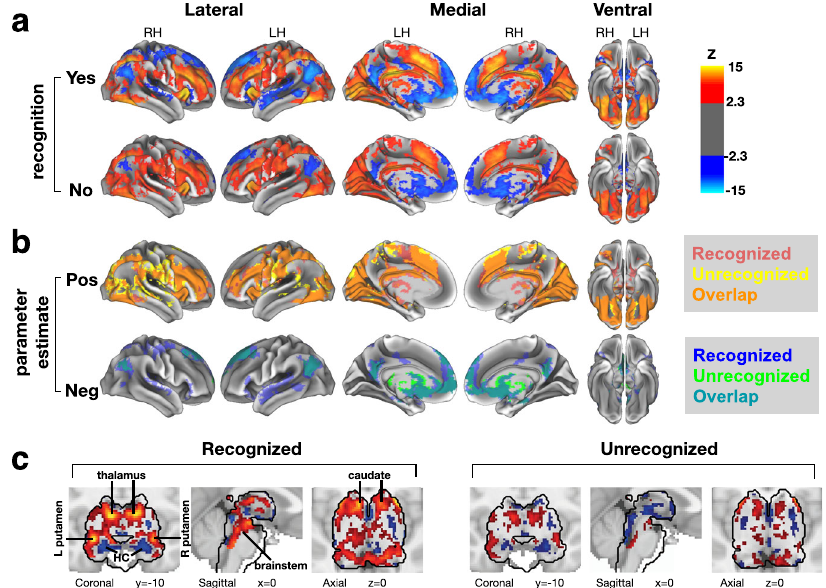
Fig. 2 Widespread brain response to liminal object stimuli. a Statistical parametric maps of BOLD response to liminal object stimuli that were subsequently recognized (Yes, top row) and unrecognized (No, bottom row), plotted on an in fl ated cortical surface template. b Same data as in a , showcasing the overlap in brain areas exhibiting positive ( “ pos ” ) and negative ( “ neg ” ) responses from baseline according to GLM parameter estimates. The positive and negative responses indicate activation and deactivation, respectively. c Same analysis as a presenting activity in subcortical regions only (within black contour), whereas the cortical activity shown in a is excluded for clarity (plotted on MNI152 template brain volume). The results are shown for voxels exhibiting signi fi cant p -values only, which were determined using cluster-based FWE-correction in FSL, with a voxel-de fi ning Z statistic threshold of p < 0.01 and a cluster size threshold of p <